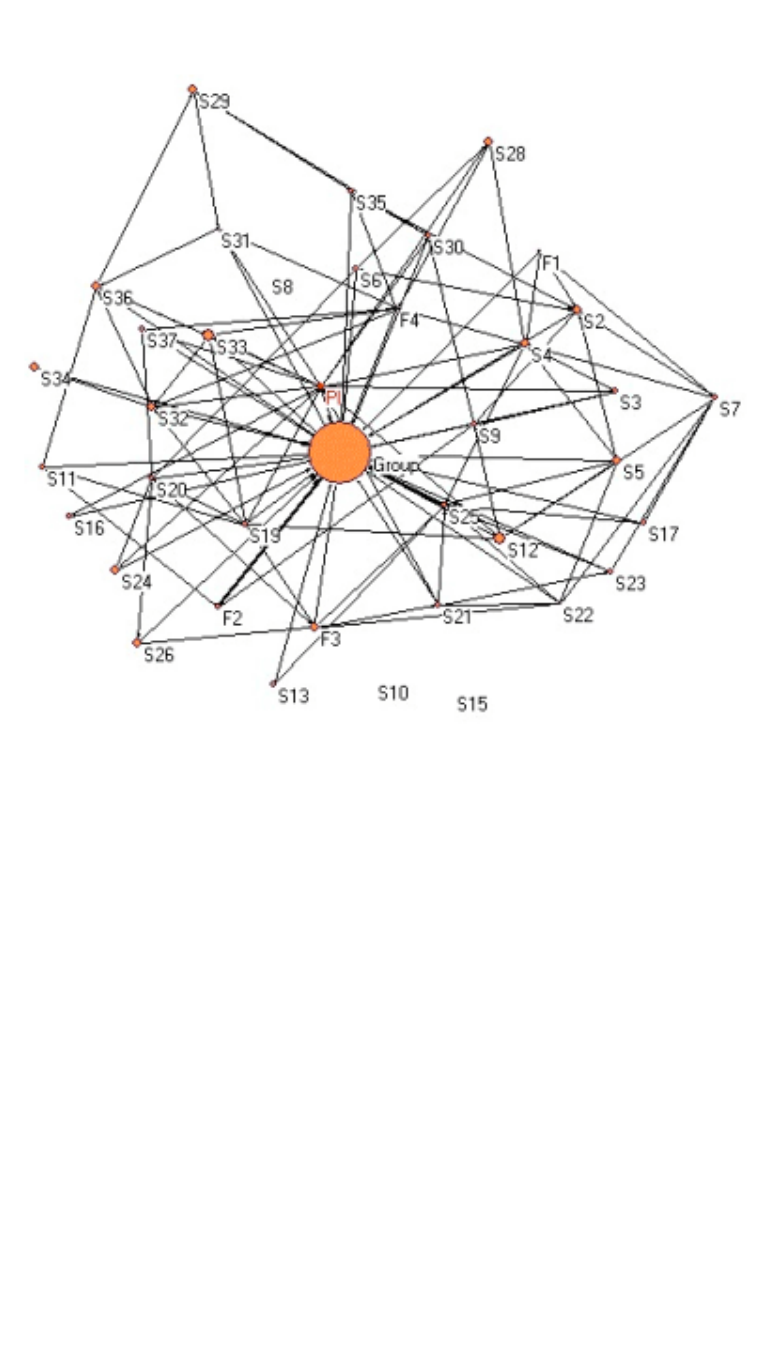
Figure 1. Online Session 2 Participation Pattern Diagrams for 30 minutes of processing after the activity. “S” refers to the students, “PI” refers to the principle instructor, and “F” refers to the